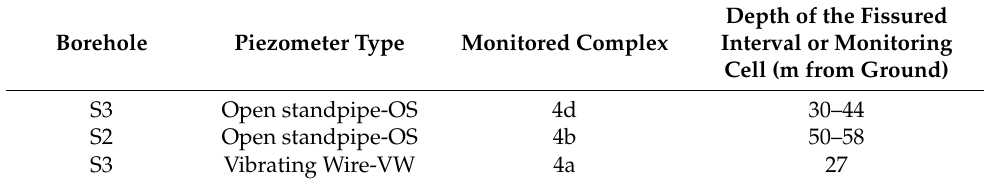
Table 4. List of piezometer types, monitored complex, and depth of the screened interval or moni- toring cell.